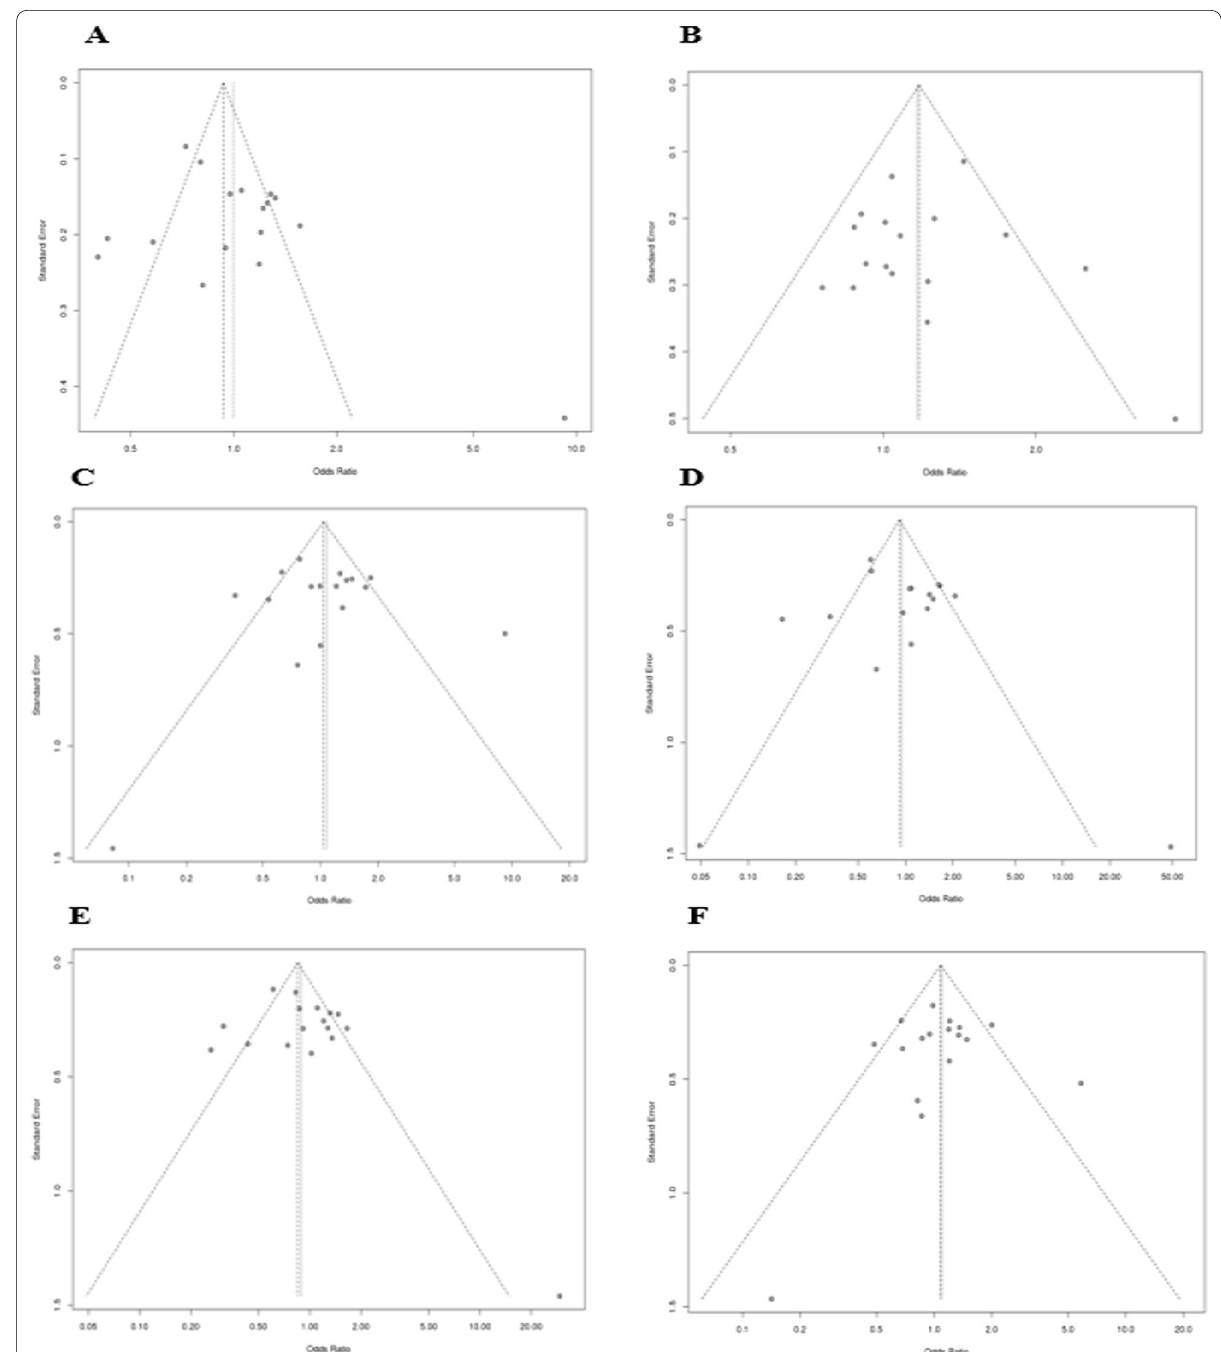
Fig. 4 Final publication bias analysis for rs2277923 relationship with CHDs and the funnel plot for different genetic models showing results as a allelic, b overdominant, c dominant, d recessive, e homozygote, and f